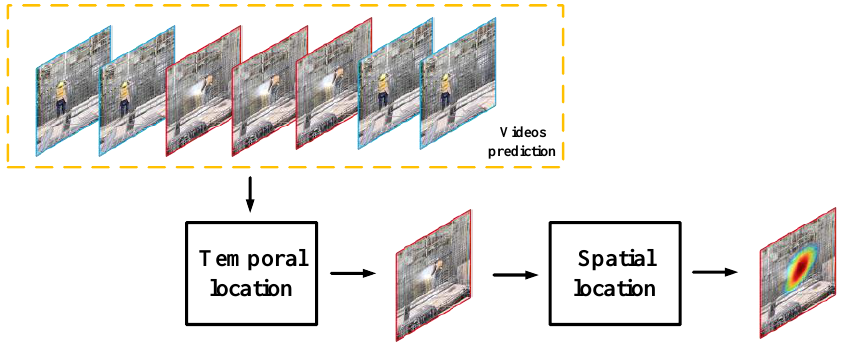
Figure 1. Key elements of proposed